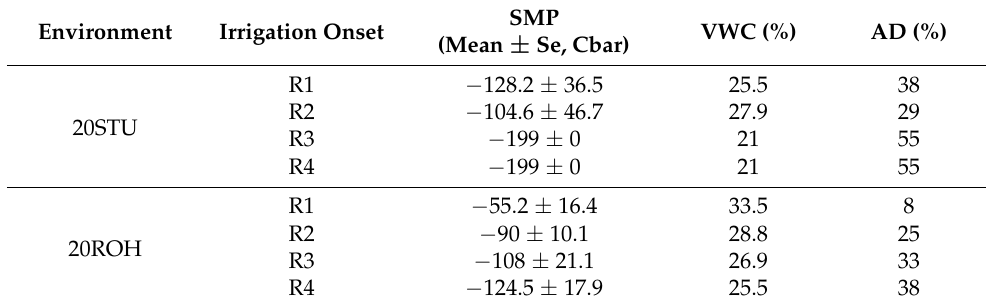
Table 1. Average soil matric potential (SMP), soil volumetric water content (VWC), and allowable depletion (AD) at the time of canopy wilting rating for different irrigation onsets in two environments 20STU and 20ROH (15–30 cm depth).